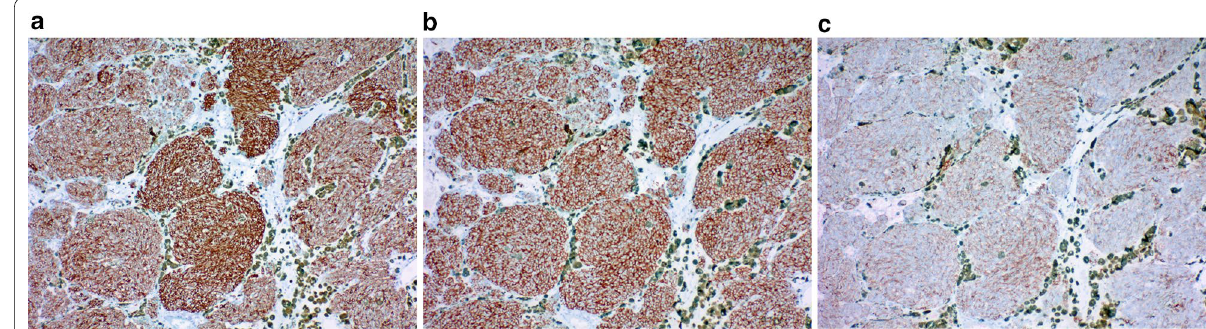
Fig. 3 Immunoreactivity of the tumor cells revealing the epithelial and neuroendocrine nature. a Cytokeratin AE1/AE3. b Synaptophysin. c